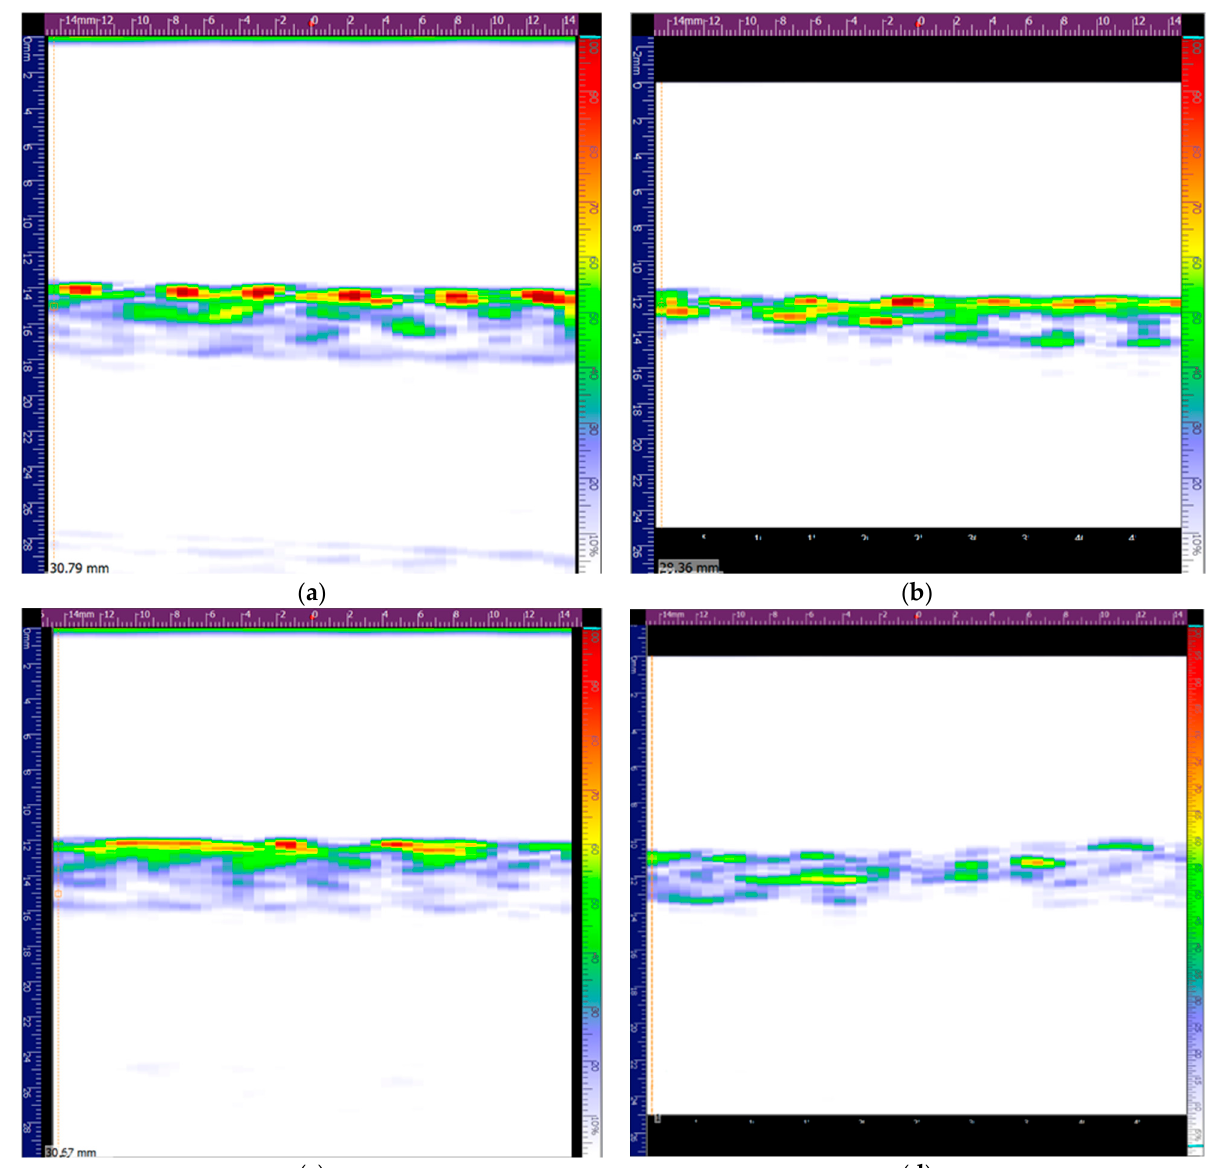
Figure 8. Phased array ultrasonic analysis of SDOF in location B0 prior to ( a ) and after ( b ) the first impact and of SDOF in location M-45 prior to ( c ) and after ( d ) first impact.